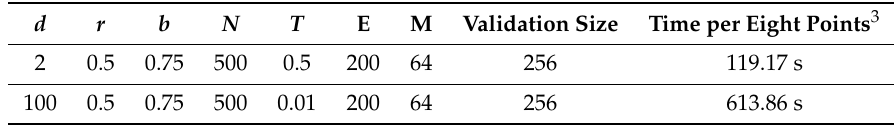
Figure 1. Approximate solution (blue) and reference solution (green) for the Poisson equation on the R 2 ( left ) and on the R 100 ( right ). Table 1. Parameters for the Poisson